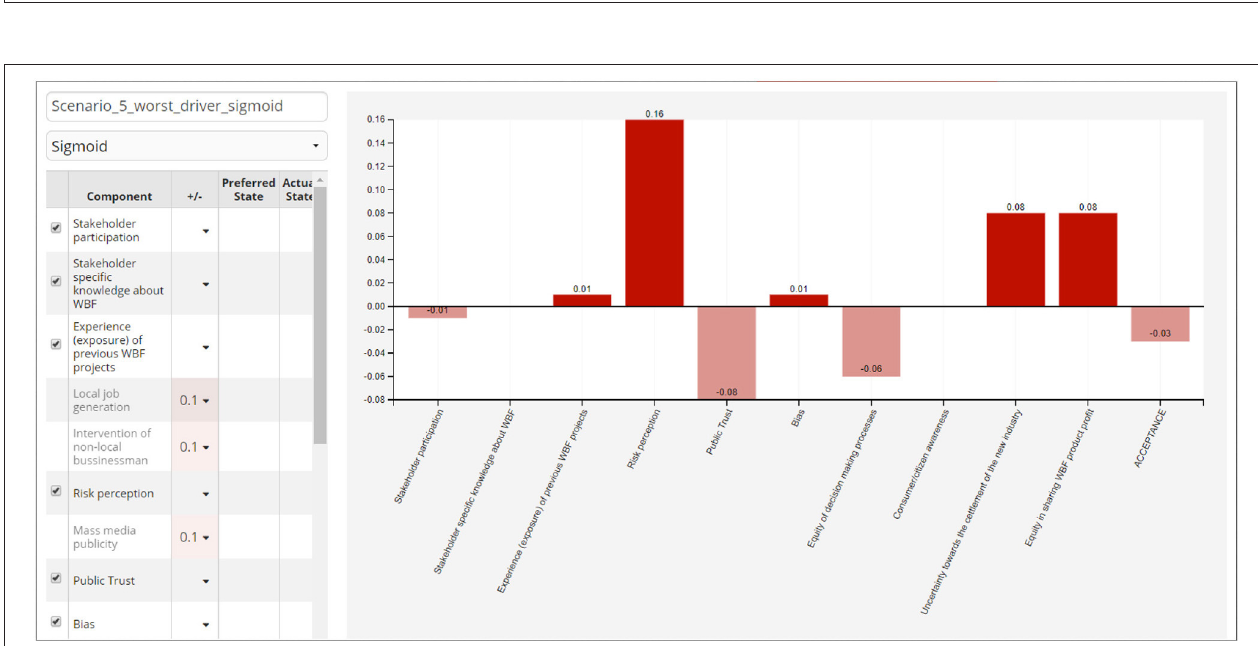
FIGURE 6 | Indicative dynamic simulation of the Social_FCM with the converged values of the social concepts and the corresponding curves of concept activation levels per each iteration.